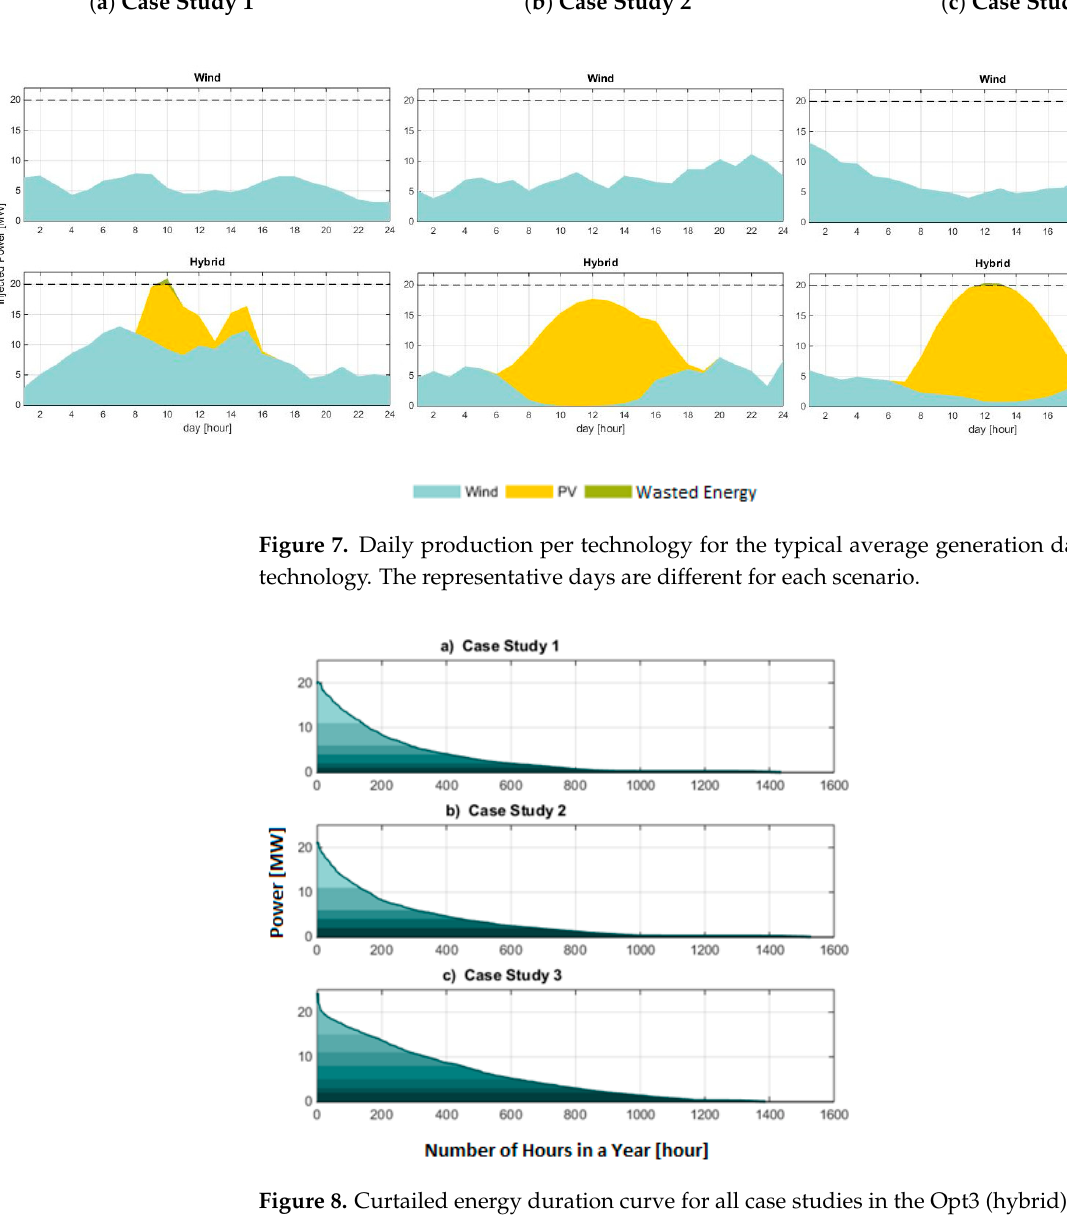
Figure 7. Daily production per technology for the typical average generation day profile of each technology. The representative days are different for each scenario.